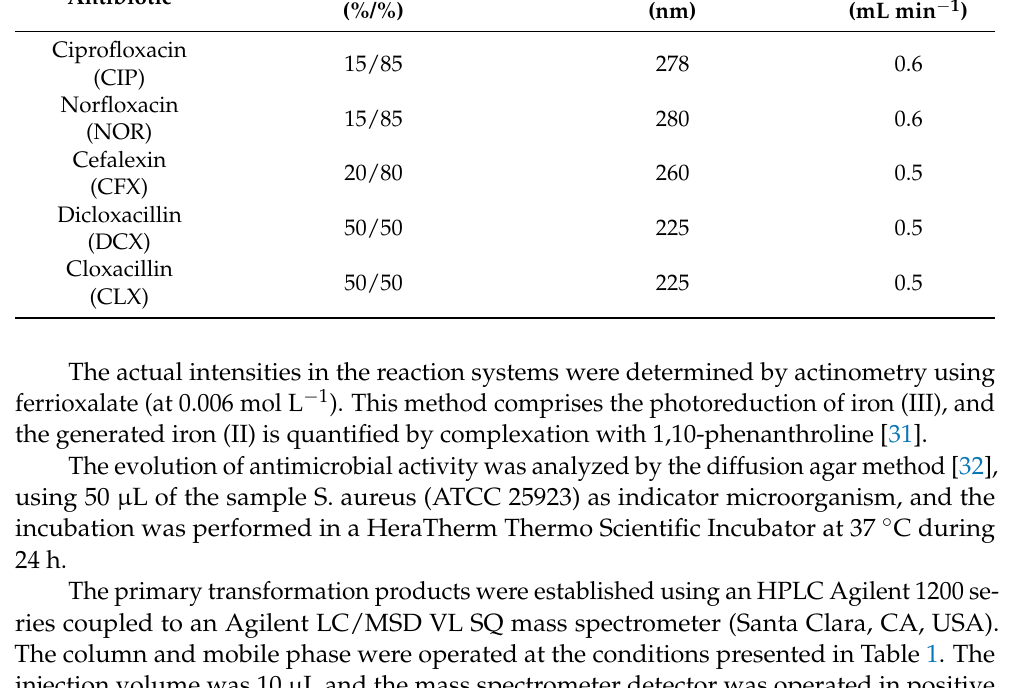
Table 1. Chromatographic conditions for the following to the degradation of the target antibiotics. Antibiotic